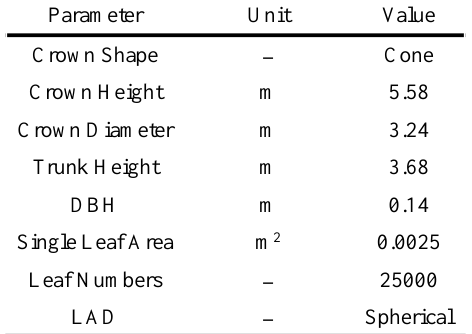
Table 2 . Single tree structure parameters.